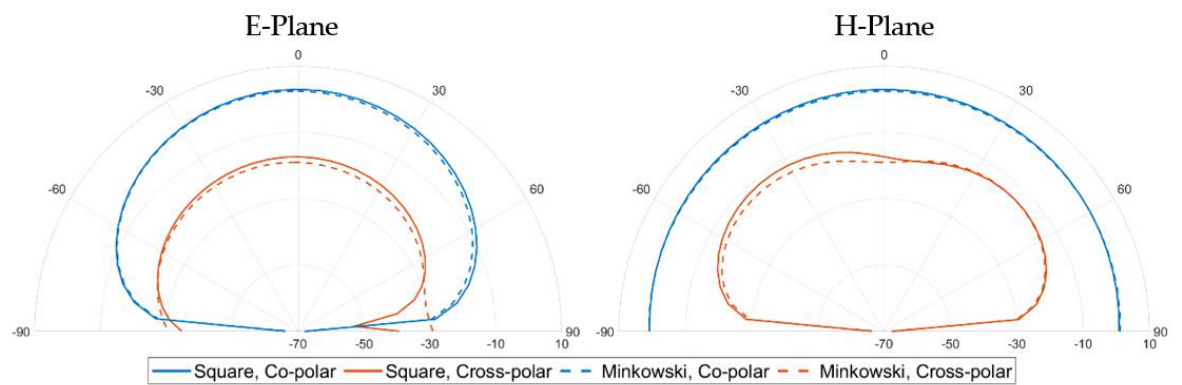
Figure 6. Simulated radiation pattern for the Minkowski pre-fractal-shaped PIFA (with T-shaped ground plane) compared to the original Square PIFA design.